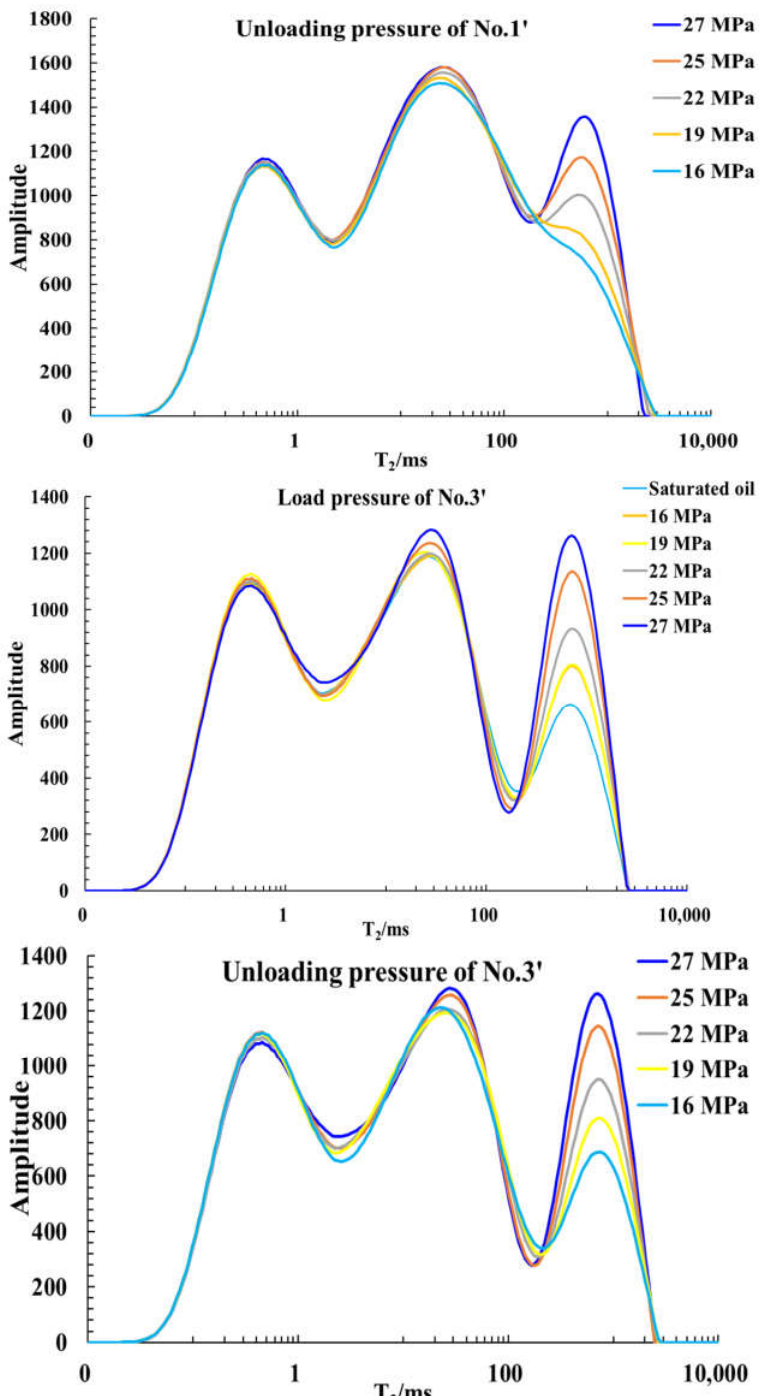
Figure 6. NMR T 2 spectrum of fractured rock samples under different pore pressures.